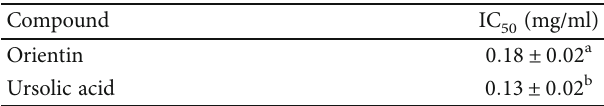
Table 5: Inhibitory potential (IC against PTP1B.